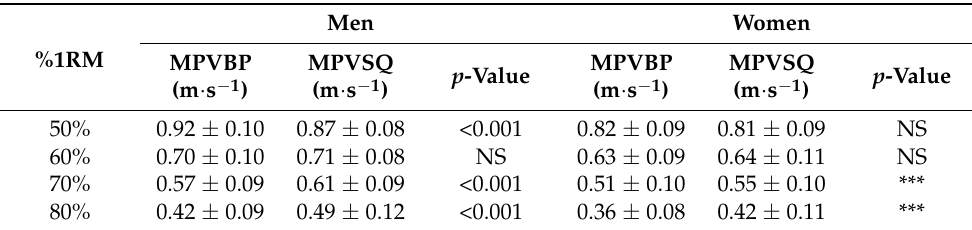
Table 3. Comparison of the MPV at the different percentages of 1RM in the bench press and full squat movements in men and